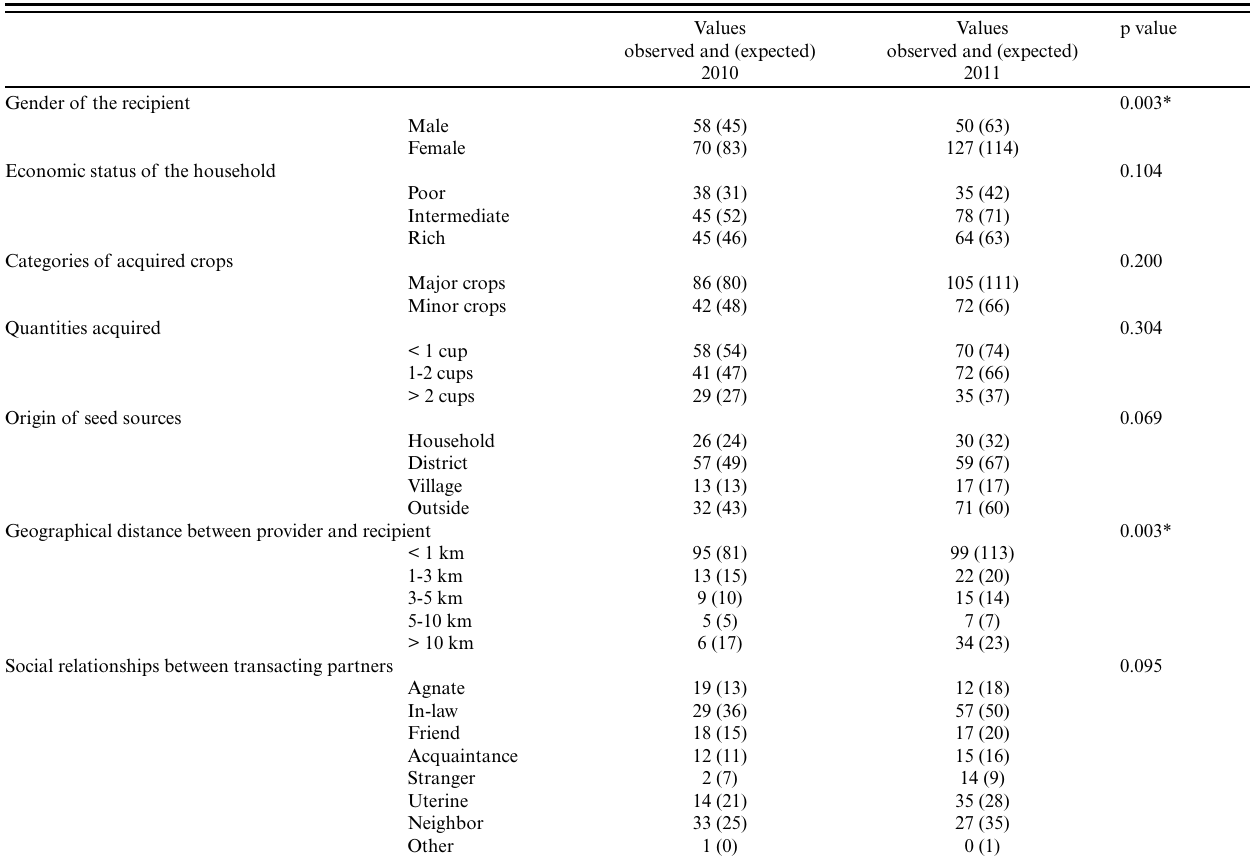
Table 1 . Distribution of seed acquisition events (observed and expected values) according to the seven variables and the two cropping seasons and results of Pearson’s chi-squared tests. Tests were considered significant (*) when p <